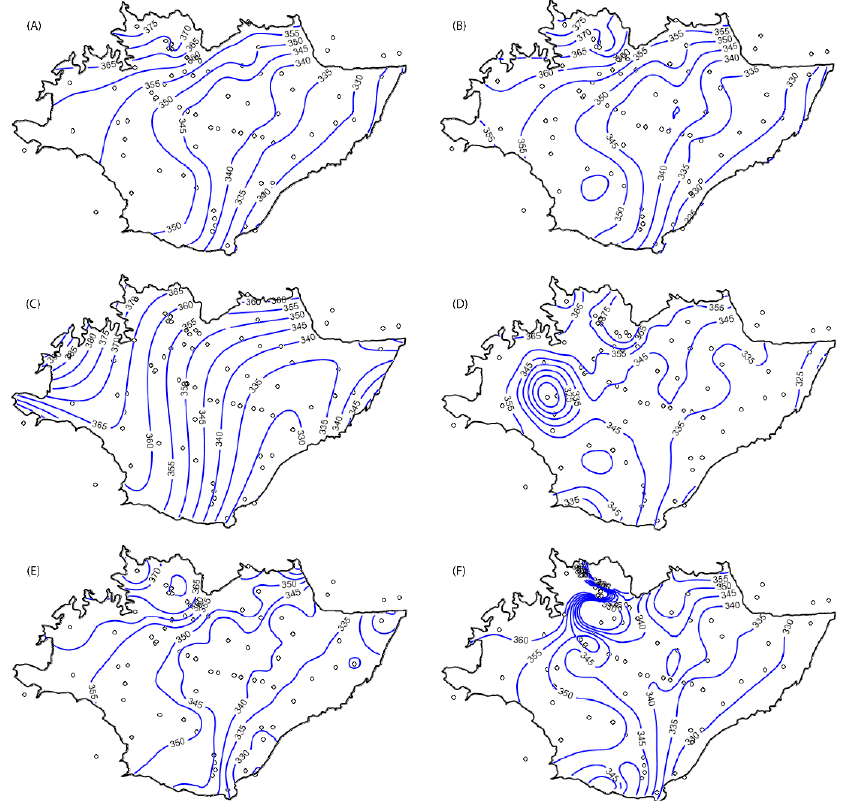
Figure 7. Spatial distribution of the water table elevation as per different geostatistical interpolation methods (field data collected over four consecutive days in February 2015): ( A ) Ordinary kriging; ( B ) minimum curvature; ( C ) polynomial regression; ( D ) modified Shepard’s method; ( E ) inverse distance to power; ( F ) radial basis function.